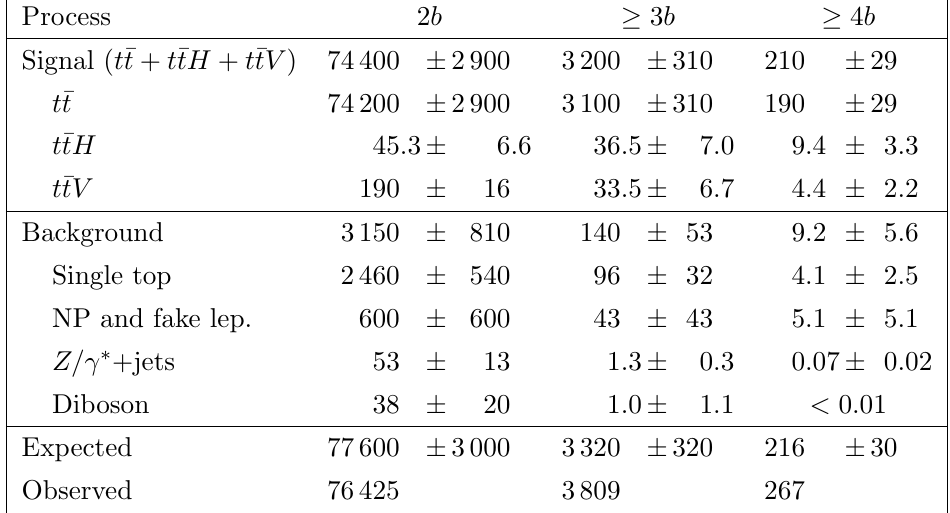
Table 2. Predicted and observed e(cid:22) channel event yields in 2 b , (cid:21) 3 b and (cid:21) 4 b selections. The quoted errors are symmetrised and indicate total statistical and systematic uncertainties in predic- tions due to experimental sources.